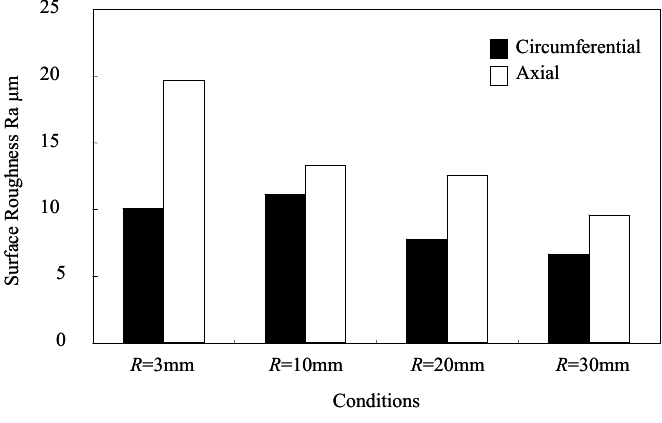
Figure 11. Surface roughness.